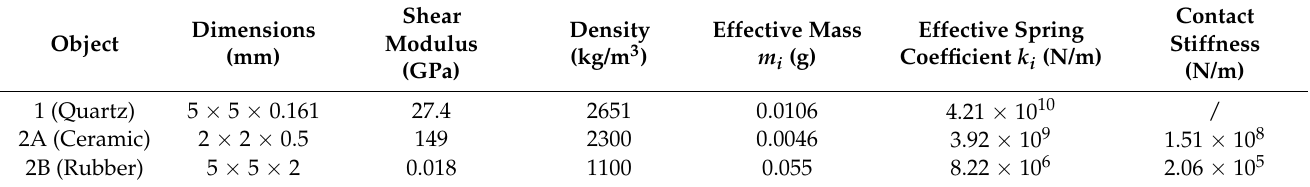
Table 1. The coefficients of an effective model for a BAW strain